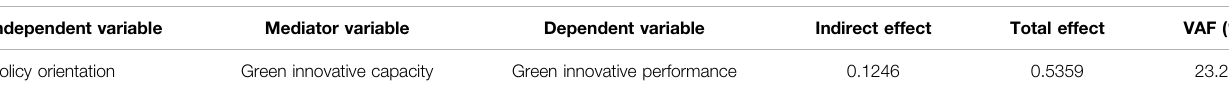
TABLE 6 | Variance accounted for (VAF) of green innovative capacity.